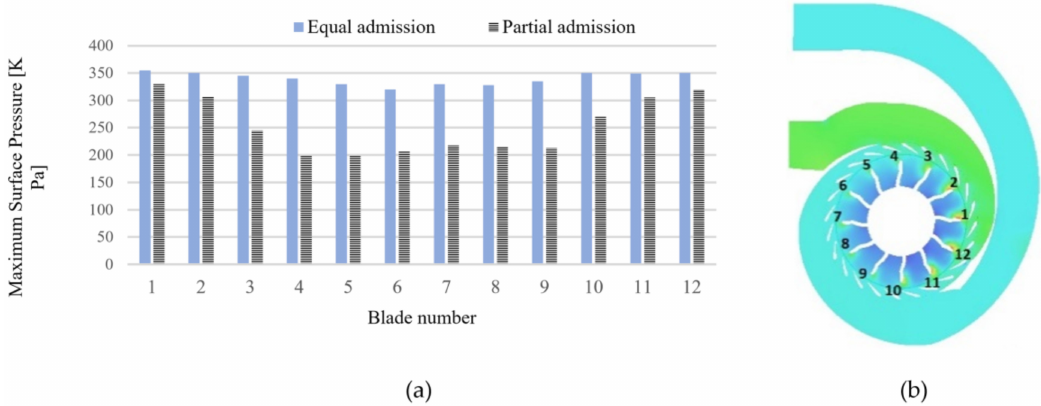
Figure 5. ( a ) Surface pressure on the all of the turbine blades in equal and partial admission; ( b ) definition of blade